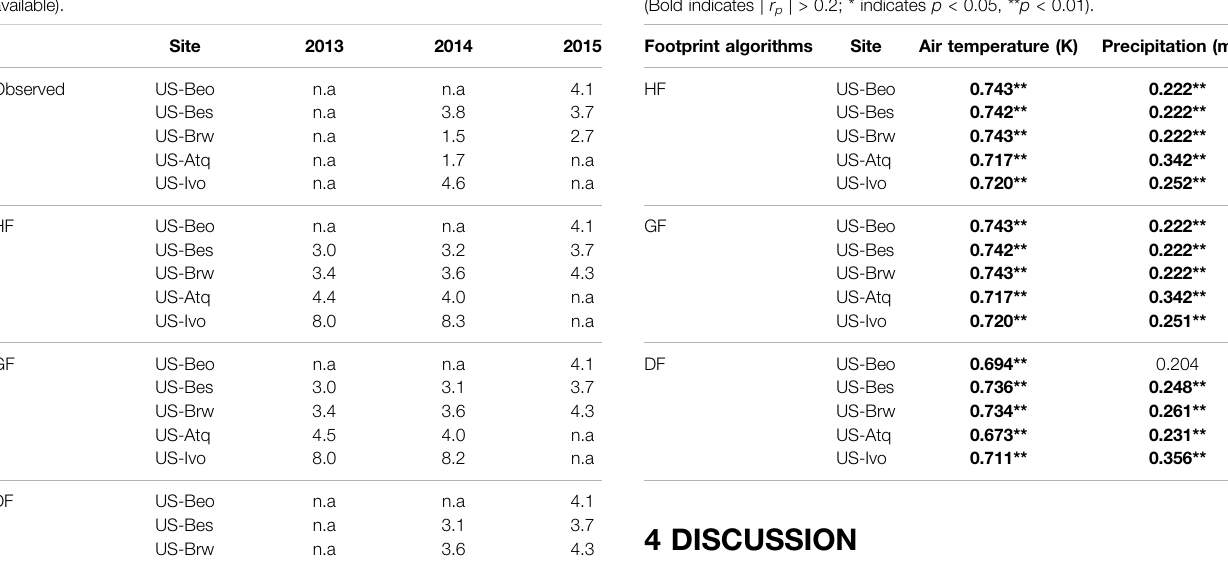
TABLE 4 | Pearson ’ s correlation coef fi cients ( r p ) for relationships between air temperature, precipitation and upscaled CH 4 fl ux using the